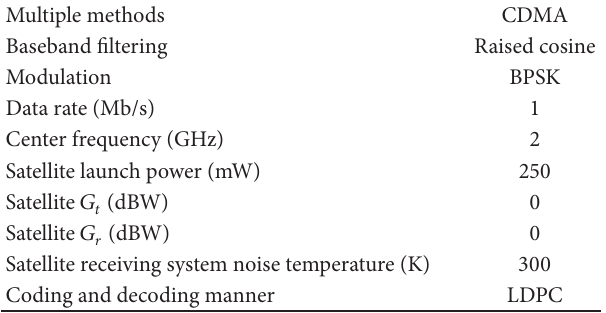
Table 2: The parameters of intersatellite